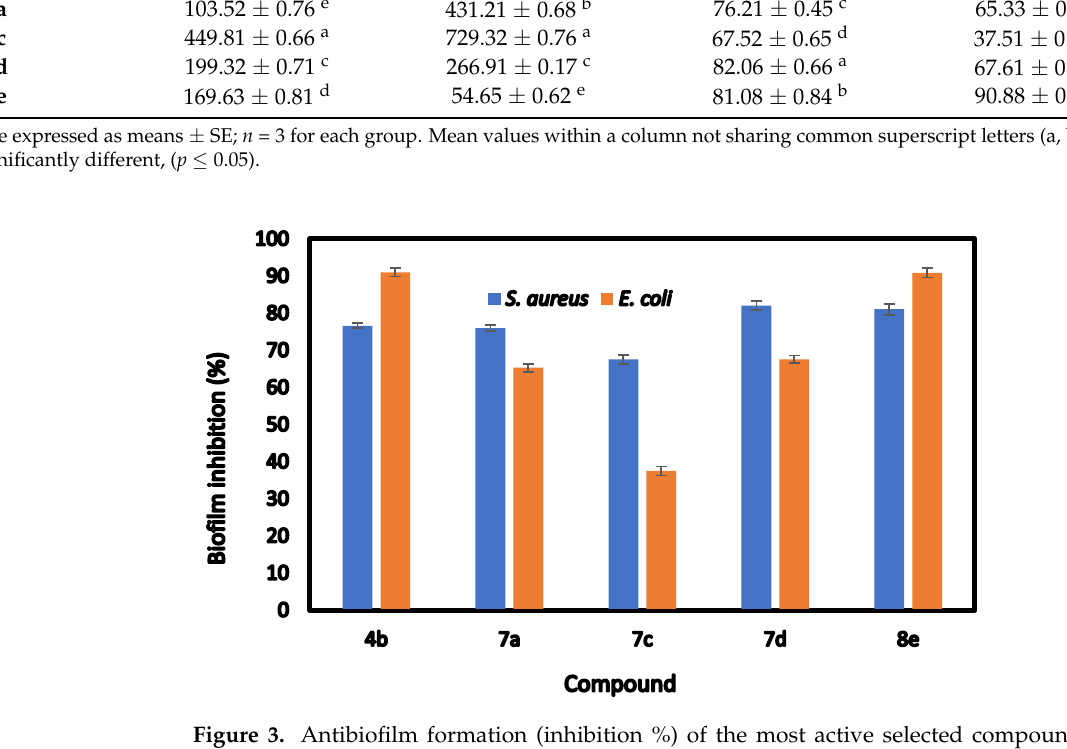
Figure 4. Antibiofilm formation (IC 50 , μ g/mL) of the most active selected compounds against Staph- ylococcus aureus (blue), and Escherichia coli (orange). Values are expressed as means ± SE; n = 3 for each group. 2.4. Release of Reducing Sugars and Proteins The leakage of biomolecules such as reducing sugars and proteins was considered as a tool explaining the effect of active compounds on test microbes [33]. All compounds exhibited release of reducing sugars and proteins more than controls ( S. aureus and E. coli ) with variable values (Table 4, Figure 5). Some antibiotics could inhibit the biosynthesis of cell wall peptidoglycan and their cell become more susceptible to osmotic lysis and thus become toxic to the bacterial cell, as human cells do not have peptidoglycan. Table 4. Reducing sugars and proteins released from Staphylococcus aureus and Escherichia coli cultures treated with the most active selected compounds compared to untreated cultures (control). Compds